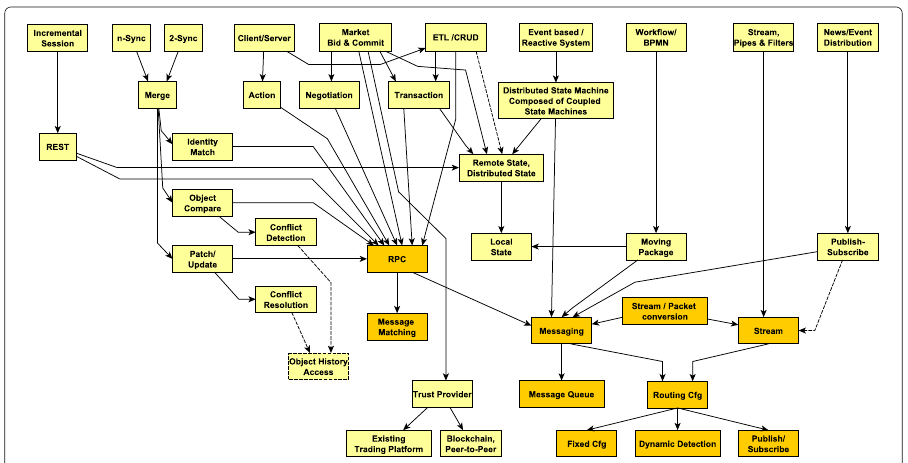
Fig. 3 Identification of technical communication procedures by analyzing the communication patterns of use-cases